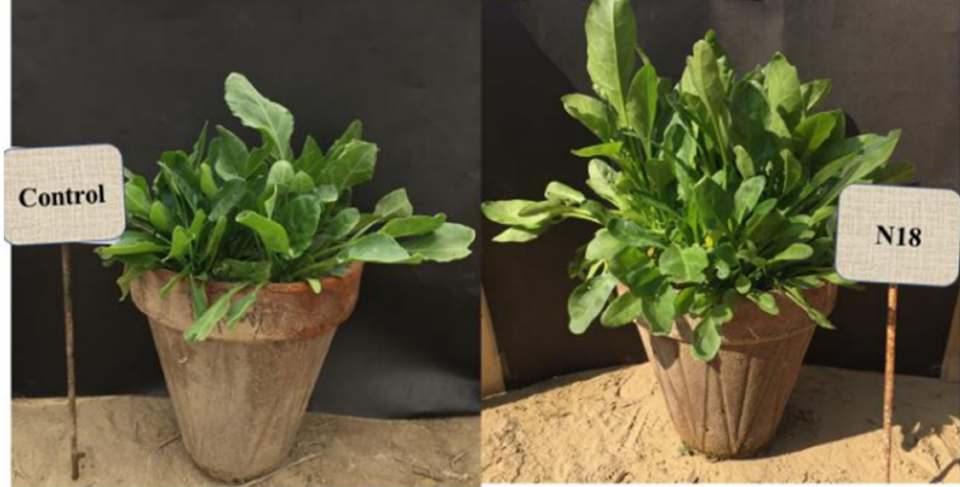
Figure 1. Effect of Pb-tolerant Bacillus strain and treated wastewater on spinach in a pot